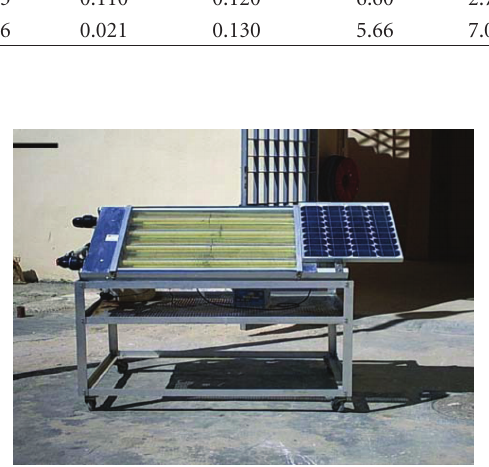
Figure 1: Photograph of the autonomous AQUACAT solar pilot